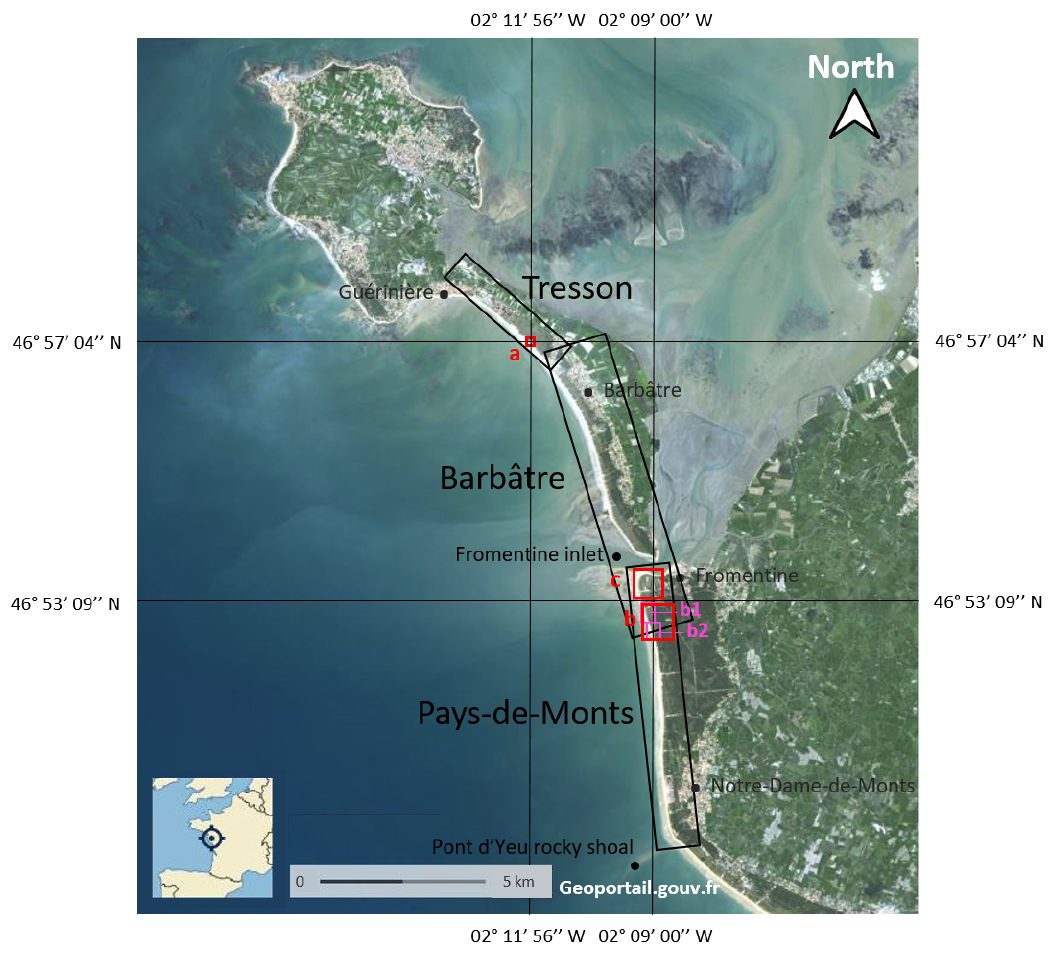
Figure 2. Location of the study areas: Noirmoutier Island and the north part of Pays-de-Monts, in western France. Here are noted: the working area “Tresson” and the validation areas “Barbâtre” (available in the appendix) and the north part of “Pays-de-Monts”. ( a ) Represents the dGPS field sampling location of the working area, ( b ) represents Dame-de-Monts subsidiary validation area 1, with b1 and b2 corresponding to the dGPS field sampling location of the validation area and ( c ) Dame-de-Monts subsidiary validation area 2. Image from